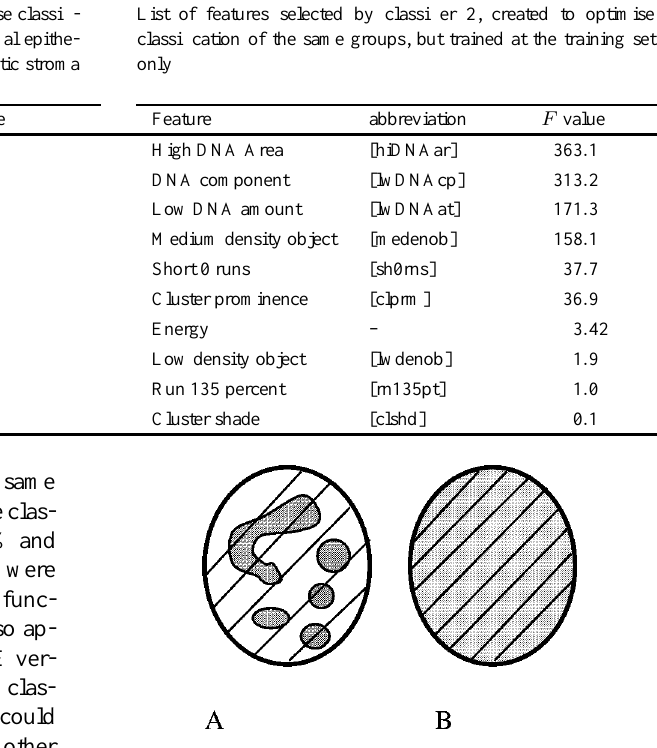
Fig. 2. Nucleus containing disconnected areas of high-density chro- matin. This nucleus would reveal a high value of “high DNA area” and “short 45 runs” (A). Nuclei with disperse low-density chromatin reveal lower values for both features (B). As features describing pixel arrays depend on directions, they cannot be regarded as rotationally